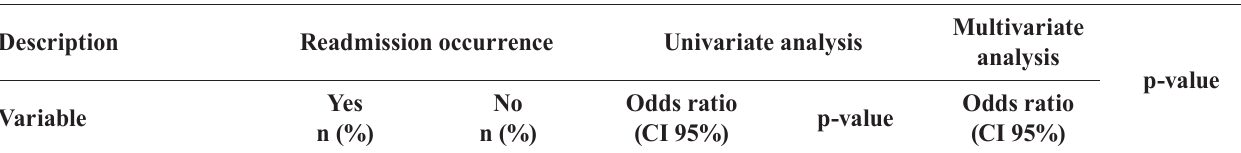
TABLE II – Univariate and multivariate analysis of the factors associated with the occurrence of readmission of older adults within 30